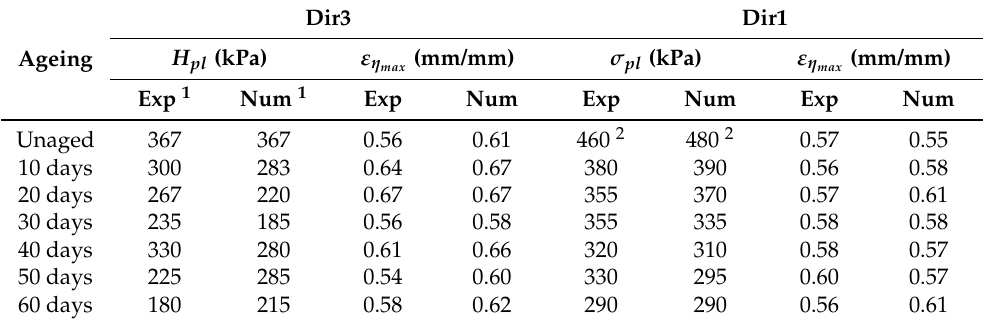
Table 1. Comparison between numerical and experimental results for each tested ageing period.